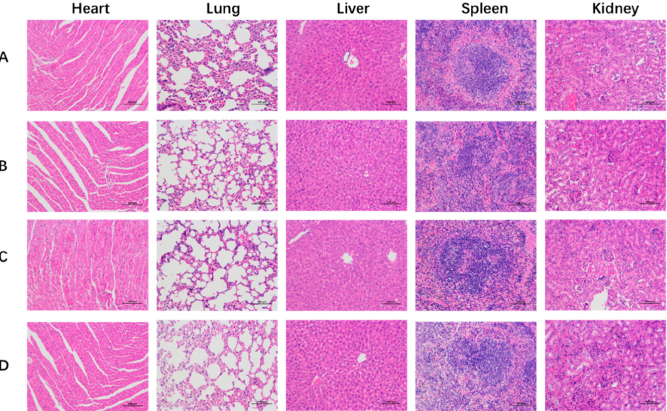
Figure 11. The histological characteristics of representative organs at 200× magnification with the optical microscope. ( A ) control group; ( B ) Dios-LP group; ( C ) CHOL-DOX-LP group; ( D ) Dios-DOX-LP group.